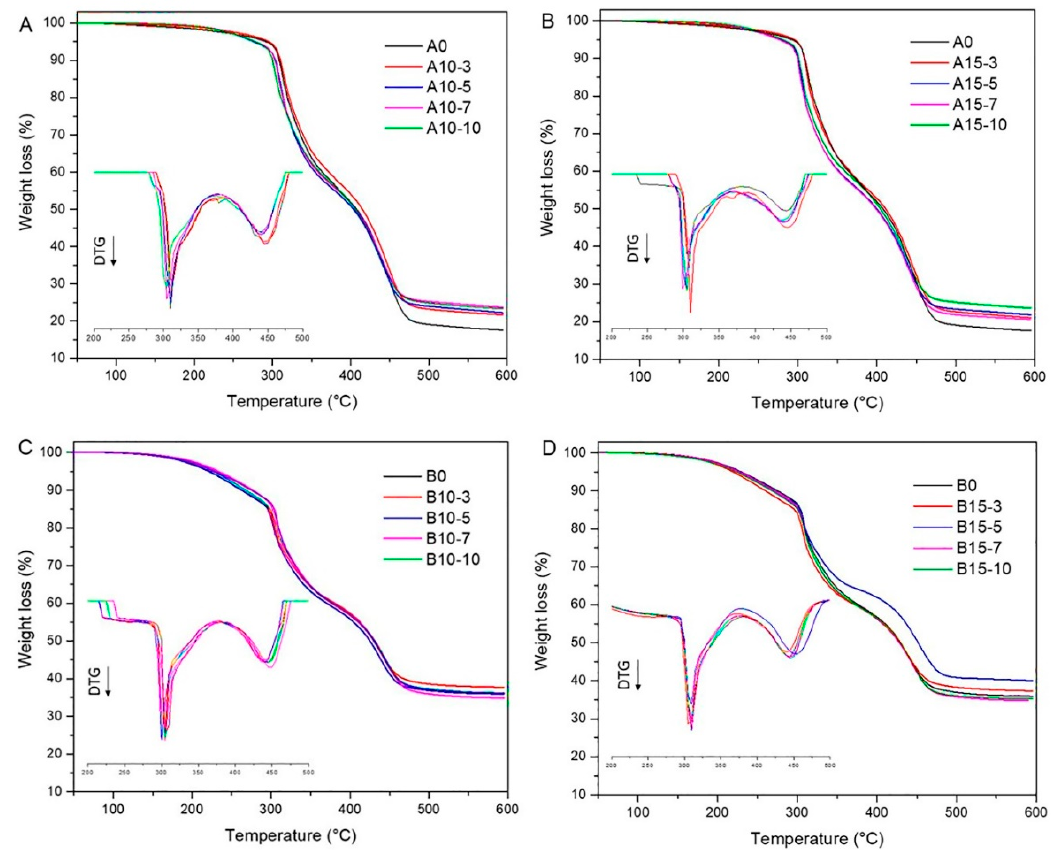
Figure 2. Thermogravimetric curves of the rubber nanocomposites containing different types and concentrations of fillers